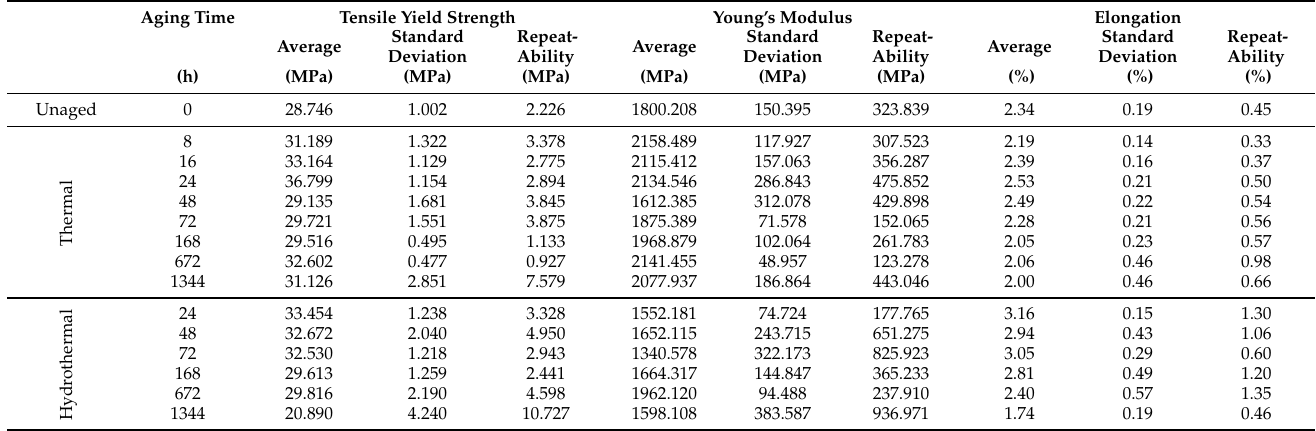
Table 3. Tensile properties of the 3D printed specimens after